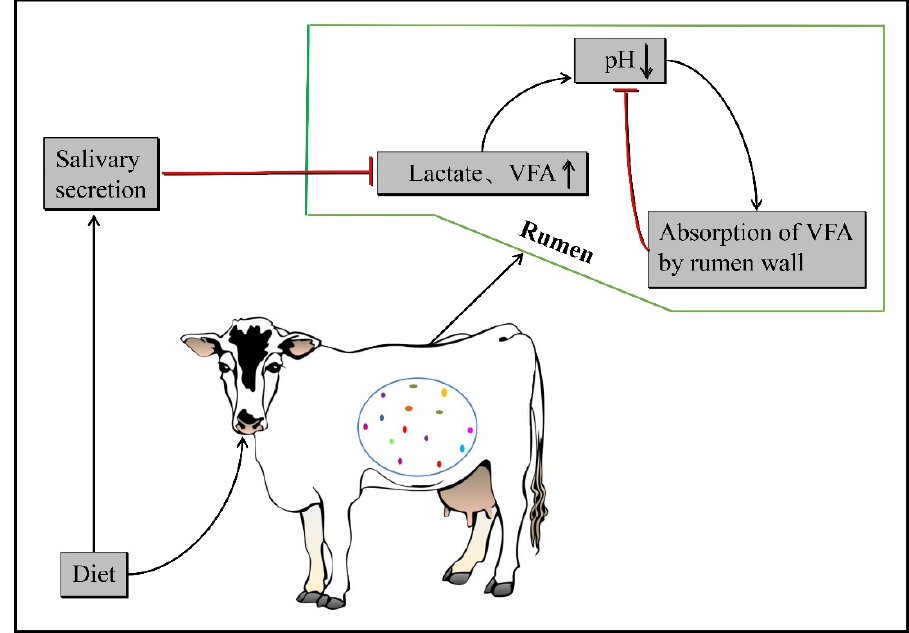
Figure 1. Physiology of the fermentation process in the rumen of dairy cows. After feeding, rumen microbes ferment the carbohydrate intake of dairy cows to produce VFA and lactate, which reduces the rumen pH. Part of the temporarily increased VFA is absorbed by the rumen wall and part is neutralized by secreted saliva to keep the rumen pH within a certain range.